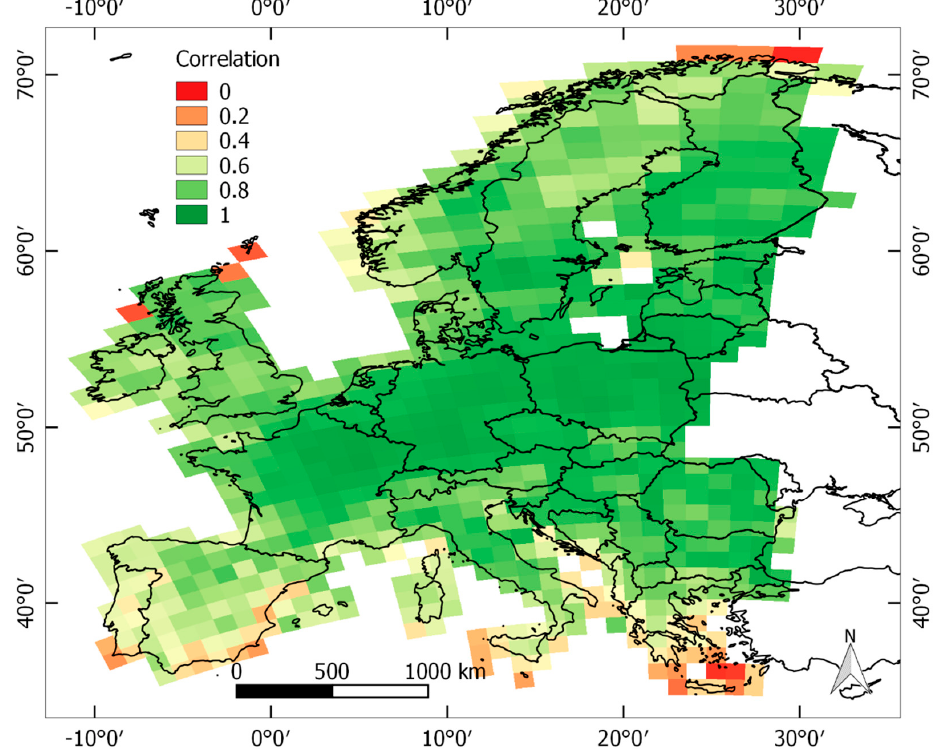
Figure 12. Pearson correlation coefficient between the Copernicus High Resolution Layers and Sentinel-1 tree cover density maps computed separately for each Equi7 tile.